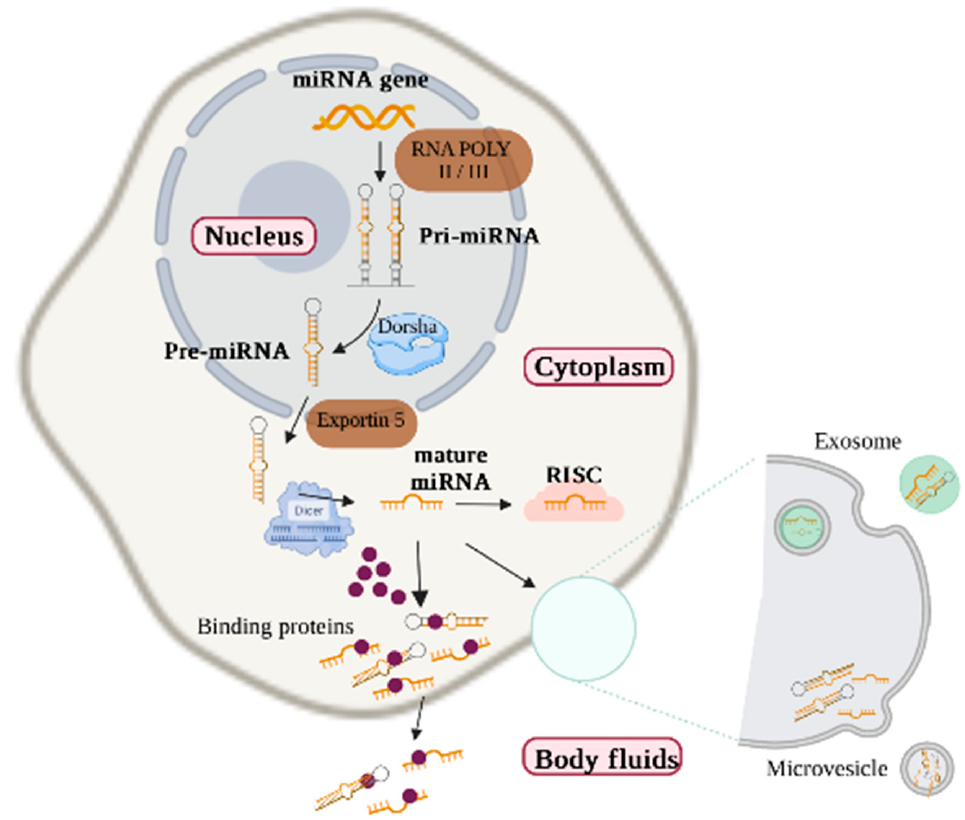
Figure 1. The biogenesis of miRNA and how they are being transported to various body fluids. Circulating miRNAs fulfil most of the ideal biomarker requirements that include high stability, specifically tissue-derived, and are easily detected by sequence-specific amplification [13]. The miRNAs were also reported to act by either destroying the target mRNA lowering its seric concentration or blocking the translation [23]. Thus, circulating miRNAs have been considered promising biomarkers for rapid diagnosis and disease management of IHD. This review aims to critically appraise and discuss the potential role of miRNAs in IHD and their use as potential